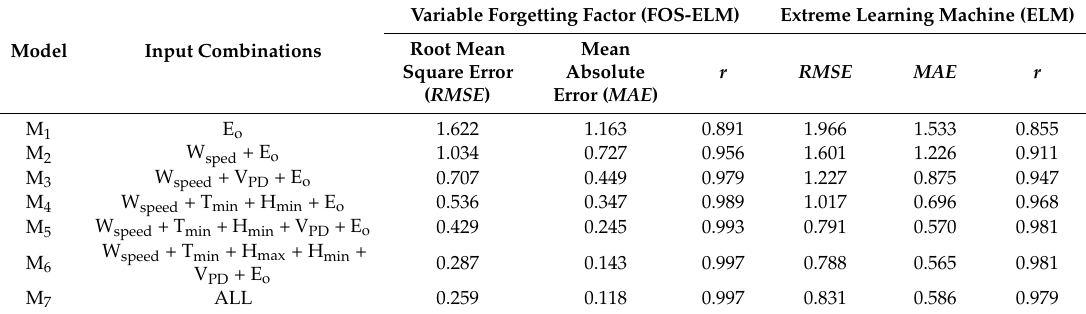
Table 1. The constructed seven input combination model based on the variability influential of each climate information (Several statistical metrics are computed as determination factors. Note, bold line is the best input combination.